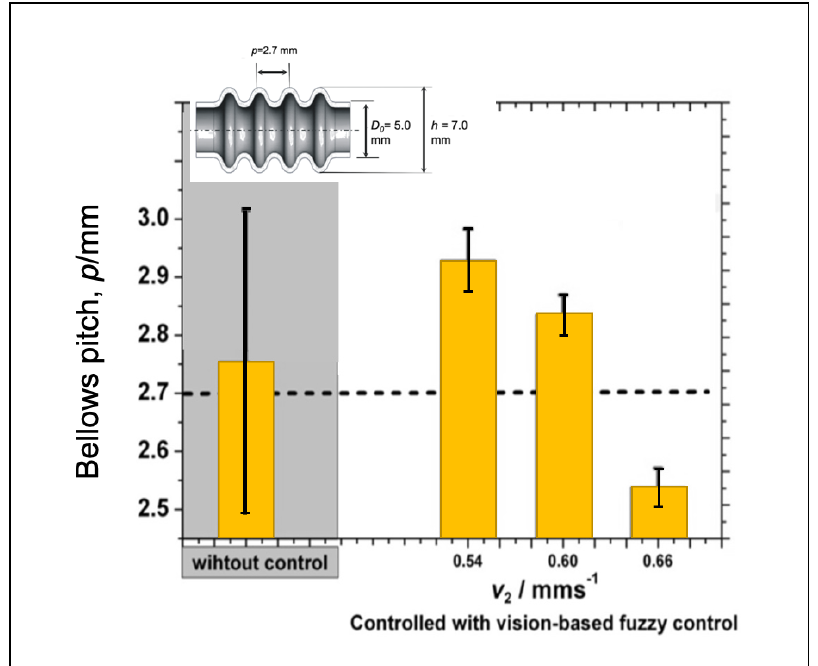
ff erent feeding